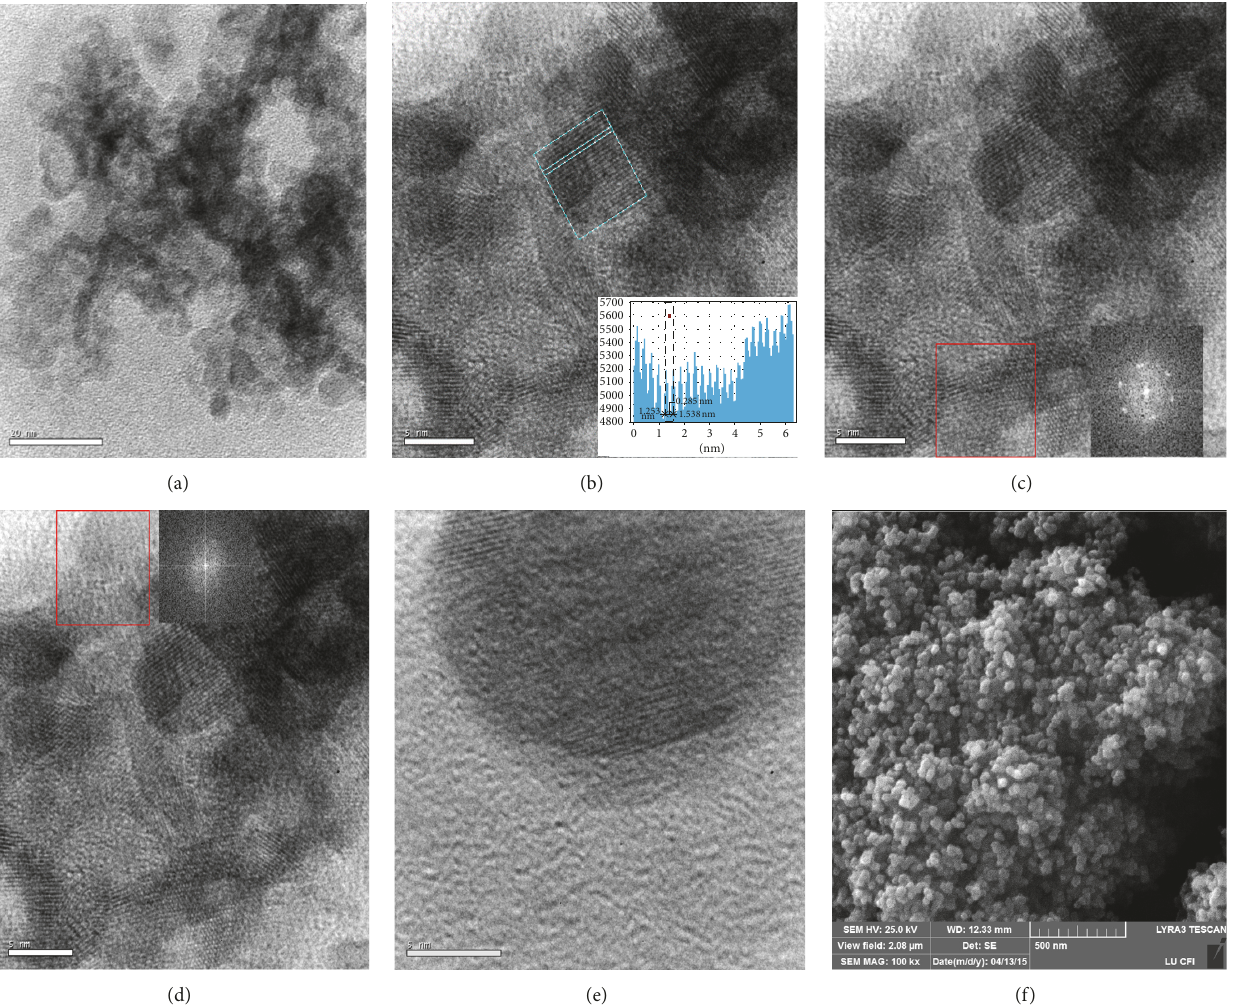
Figure 2: (a) TEM and (b, c, d, e) HRTEM images of amorphous-nanocrystalline NPles ZnO-Zn before annealing. Inset of (b) corresponds to the interlayer spacing which is about 0.285 nm, which corresponds to the interlayer distance of the (100) crystal plane of wurtzite ZnO. Inset of (c) is the corresponding FFT image from crystalline region. Inset of (d) is the corresponding FFT image from amorphous region. (e) A core-shall ZnO NPle with coating thickness of 2.5 nm; (f) SEM image of NPles ZnO-Zn annealed at 773 K in air for 1h. (SEM image in Figure 2(f) is executed by the employee of the Latvian State University (Latvia, Riga), A. Zolotarjovs.)